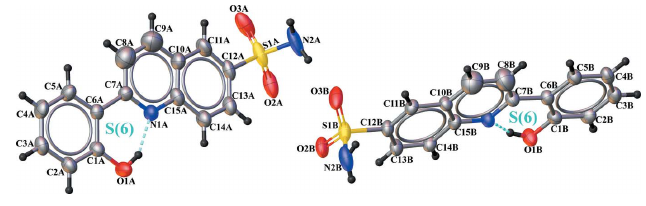
Figure 1 View of the two independent molecules of the title compound, showing the atom-labeling scheme. Displacement ellipsoids are drawn at the 50% probability level. Intramolecular hydrogen bonds are shown as dashed cyan